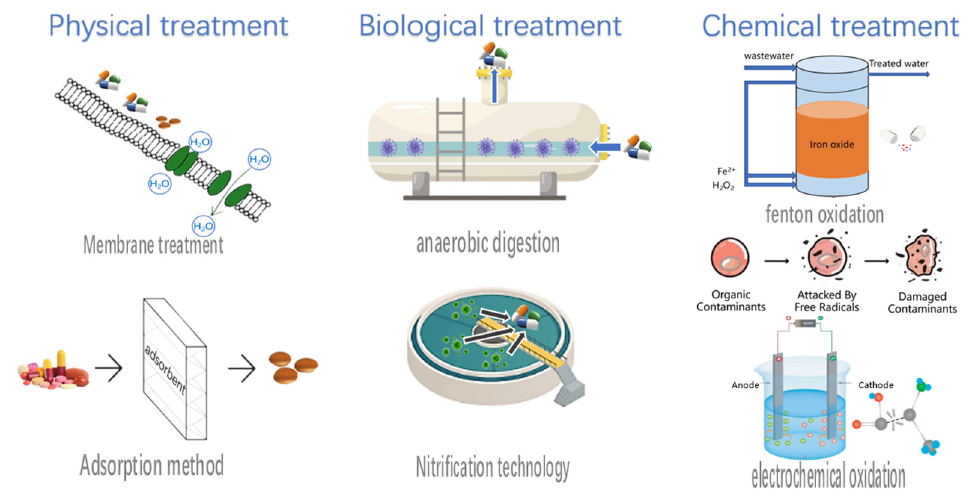
Figure 5. Model diagram of common urine treatment technology.